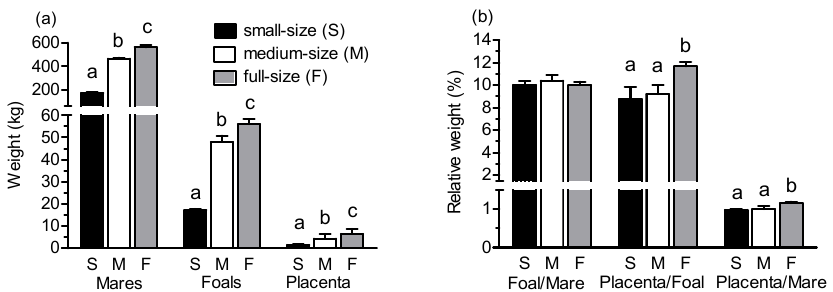
Figure 1. ( a ) Weight of mares, foals and placental weight and ( b ) relative weight (%) foal/mare, placenta/foal and placenta/mare in small (Shetland), medium-size (Haflinger) and full-size (Warmblood) horses (mares and foals on day 1 after parturition). abc Different letters indicate differences between groups ( p < 0.05).